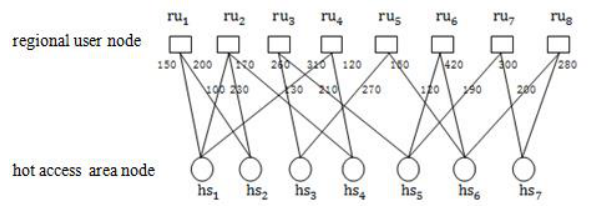
Figure 1. Weighted bipartite network example for regional